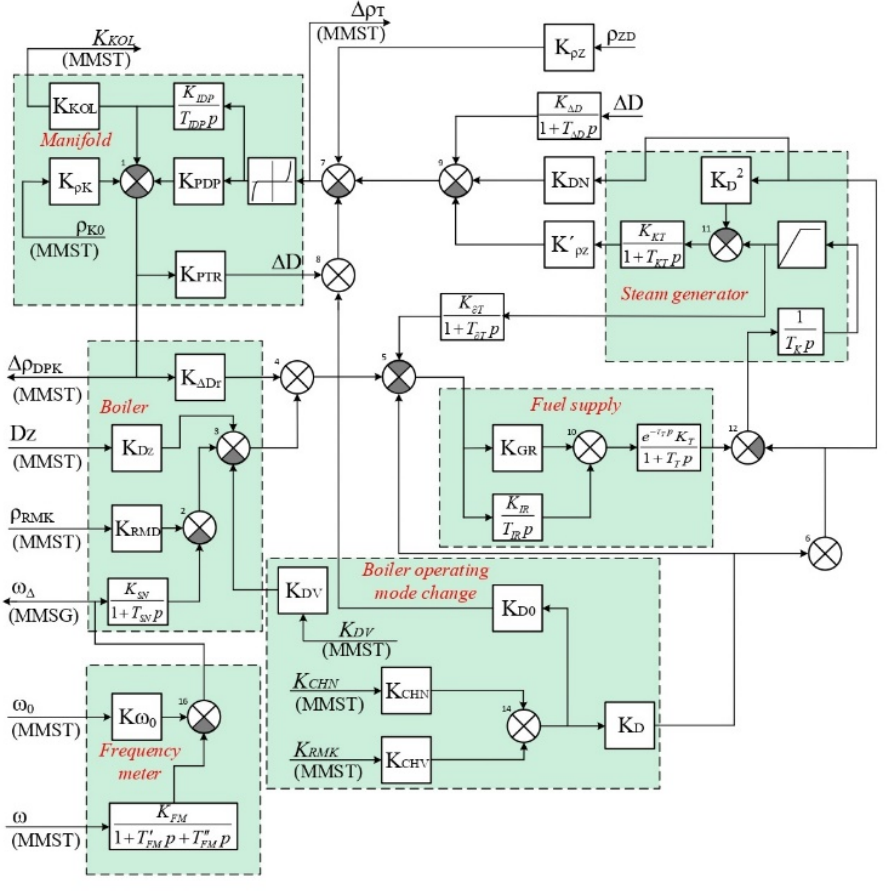
Figure 5. Mathematical model of a boiler unit.